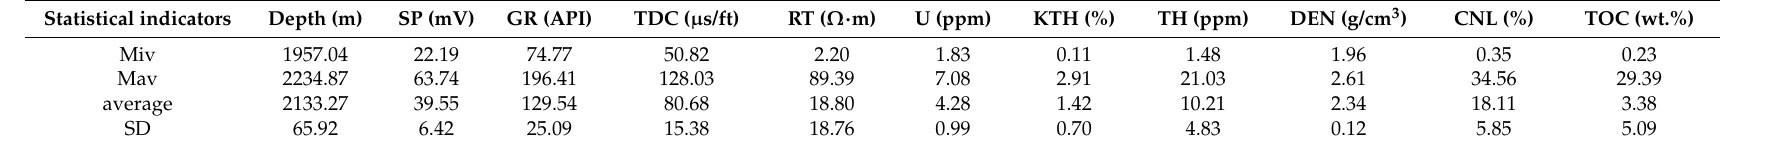
Table 1. Summary of the recorded logging parameters for Well E1.